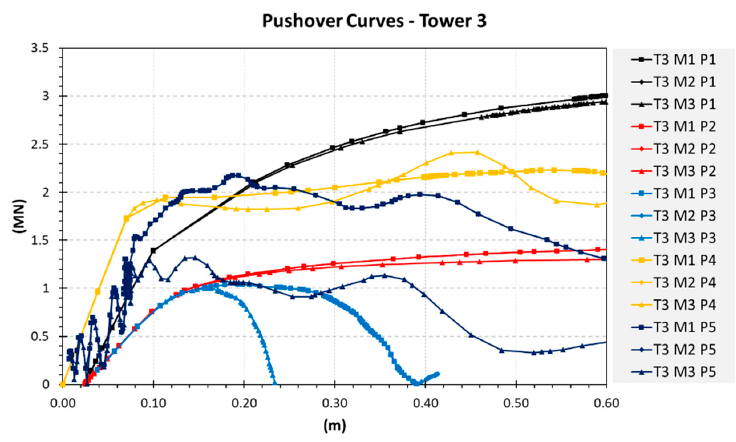
Figure A3. Pushover curves result for the case of Tower 3.